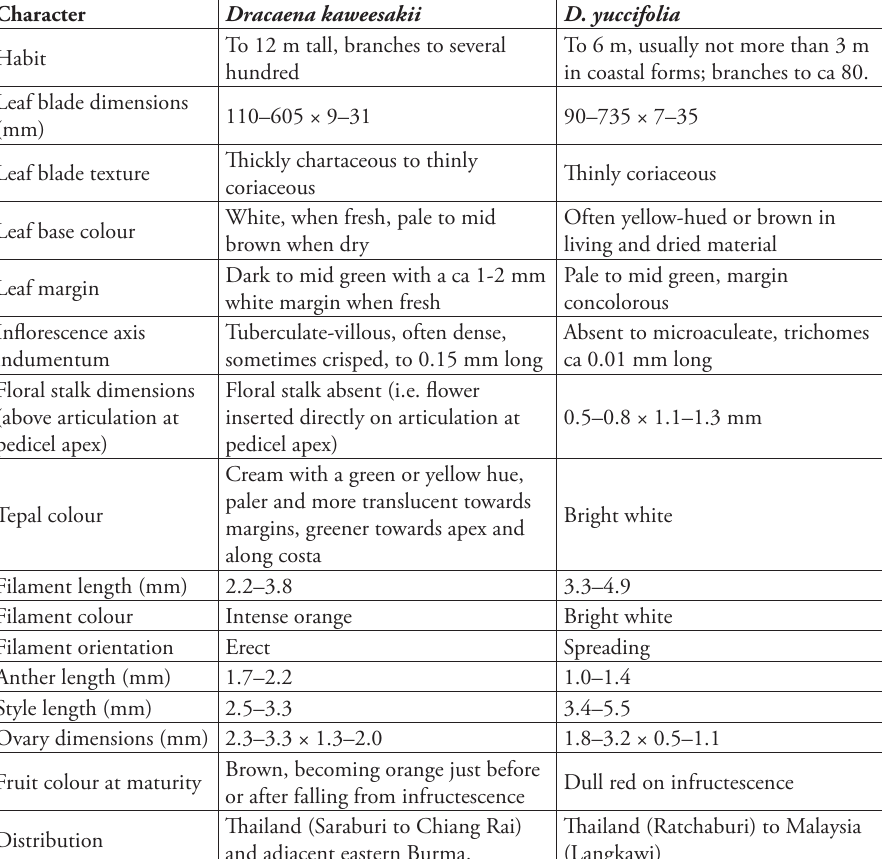
Table 1. A summary of the main morphological character state differences between Dracaena kaweesakii and D. yuccifolia